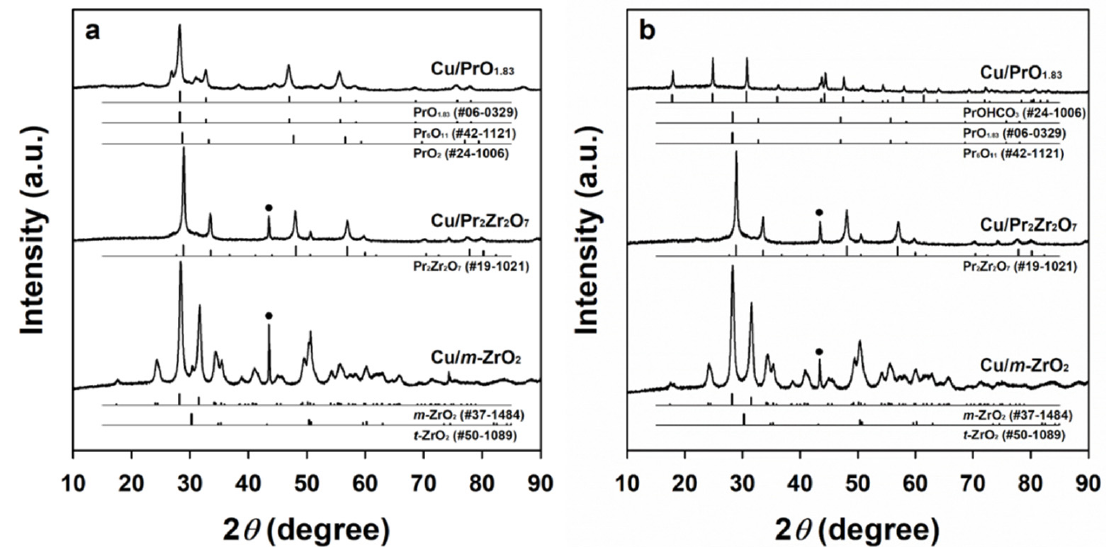
Figure 1. XRD patterns of ( a ) fresh and ( b ) spent Cu/m-ZrO 2 , Cu/Pr 2 Zr 2 O 7 , and Cu/PrO 1.83 catalysts. The symbol represents the diffraction peak of Cu (111) and the bar plots are the reference XRD patterns of PrO 1.83 , Pr 6 O 11 , PrO 2 , PrOHCO 3 , Pr 2 Zr 2 O 7 , m-ZrO 2 , and t-ZrO 2